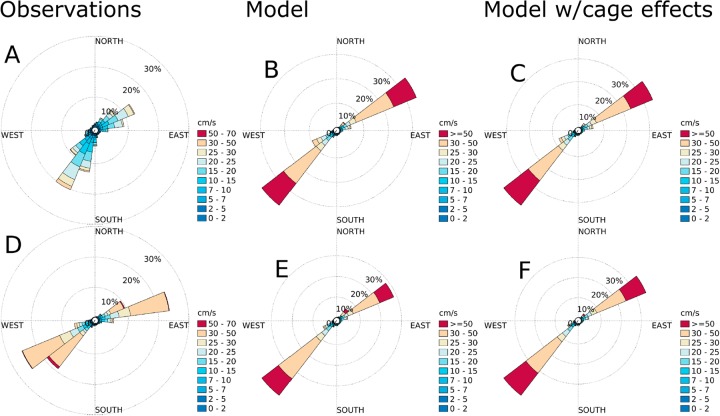
Current roses for ADCP3 (Fig 5) at 10 m depth.A: observations for August-October, 2015. B: simulation results without cage effects for August-October, 2015. C: simulation results with cage effects for August-October, 2015. D: observations for May-June, 2016. E: simulation results without cage effects for May-June, 2016. F: simulation results with cage effects for May-June, 2016. The colors indicate current speed. Each sector spans 15°.